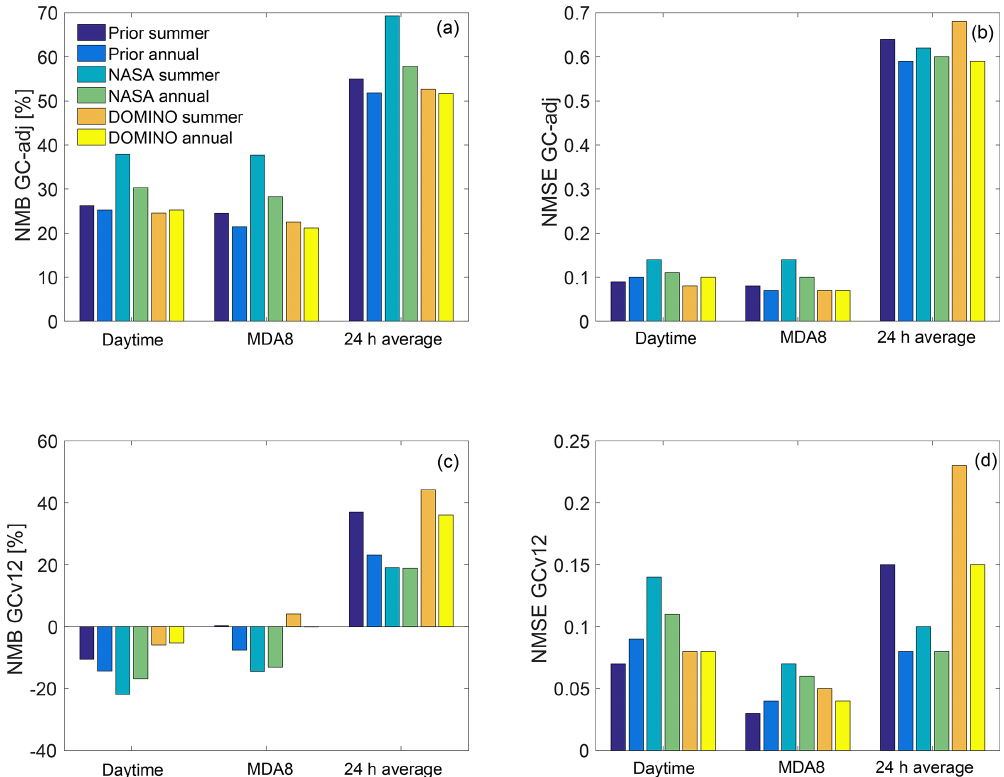
Figure 3. NMB and NMSE of annual mean and NH summertime surface ozone concentrations when comparing all measurements from TOAR in 2010 with GC-adj (a, b) and GCv12 (c, d) simulations. The simulations are input with three sets of NO x emissions: CEDS bottom- up inventory (HTAP for GC-adj and CEDS for GCv12), posterior emissions constrained by the NASA product, and posterior emissions constrained by the DOMINO